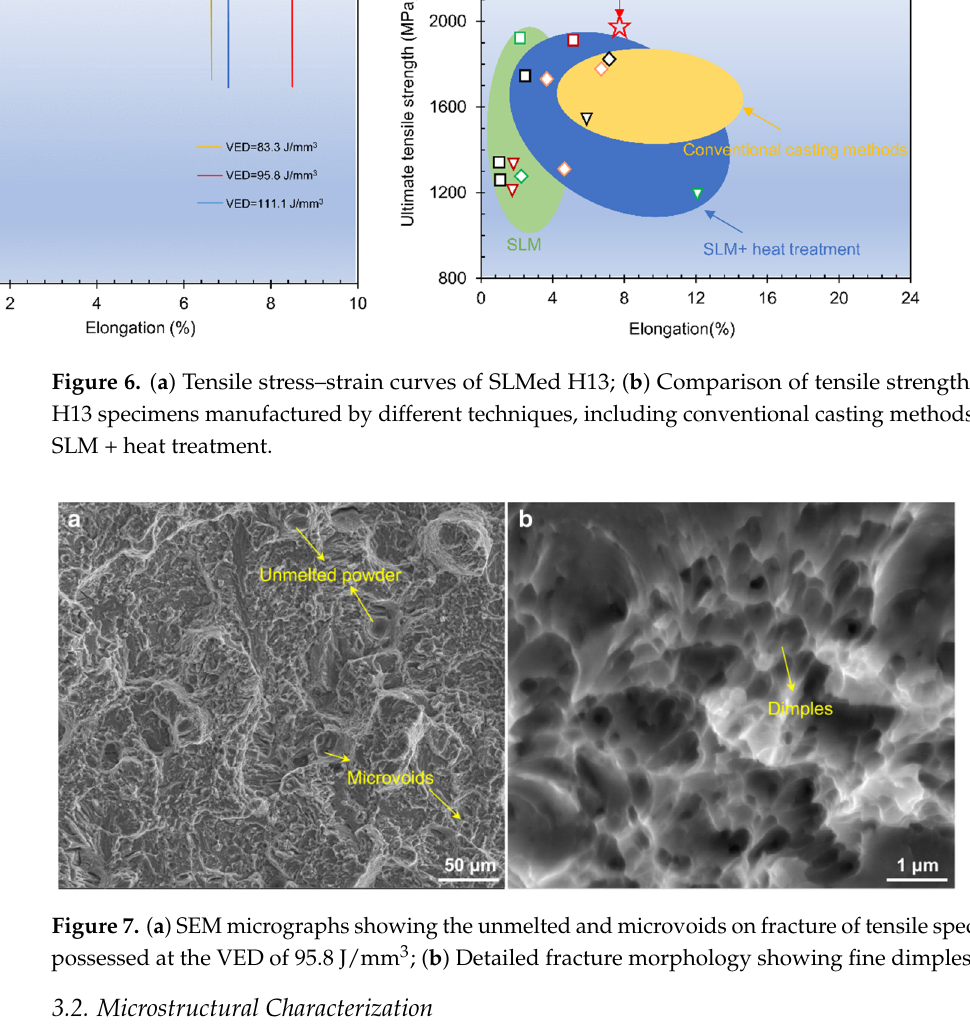
Figure 6. ( a ) Tensile stress–strain curves of SLMed H13; ( b ) Comparison of tensile strength of the H13 specimens manufactured by different techniques, including conventional casting methods, SLM, SLM + heat treatment. Table 2. Mechanical properties of the SLMed H13 samples under different conditions.